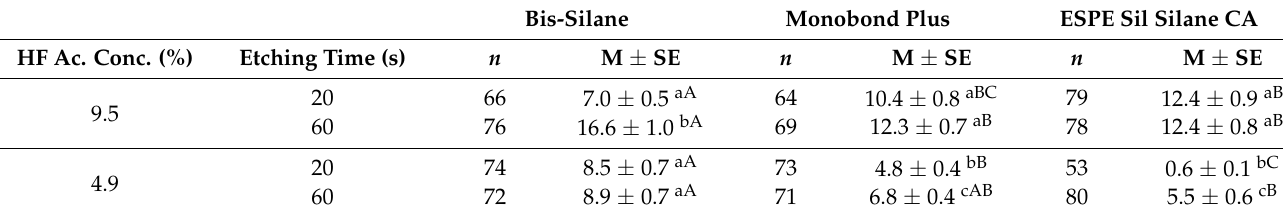
Table 2. µ TBS values (MPa) after 10,000 thermocycles (artificial aging) for the tested groups, presented as mean (M) ± standard error (SE). Total number of specimens ( n ). Monobond Etch & Prime was excluded from this table since this group had a complete pre-test failure, and thus its bond strengths could not be measured.